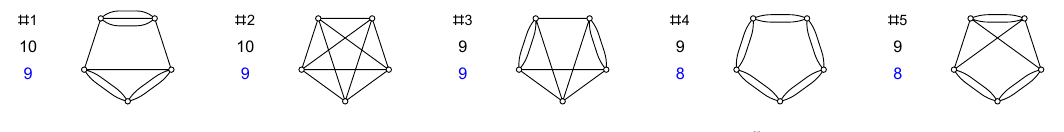
Figure 5 . All vacuum diagrams of order g 5